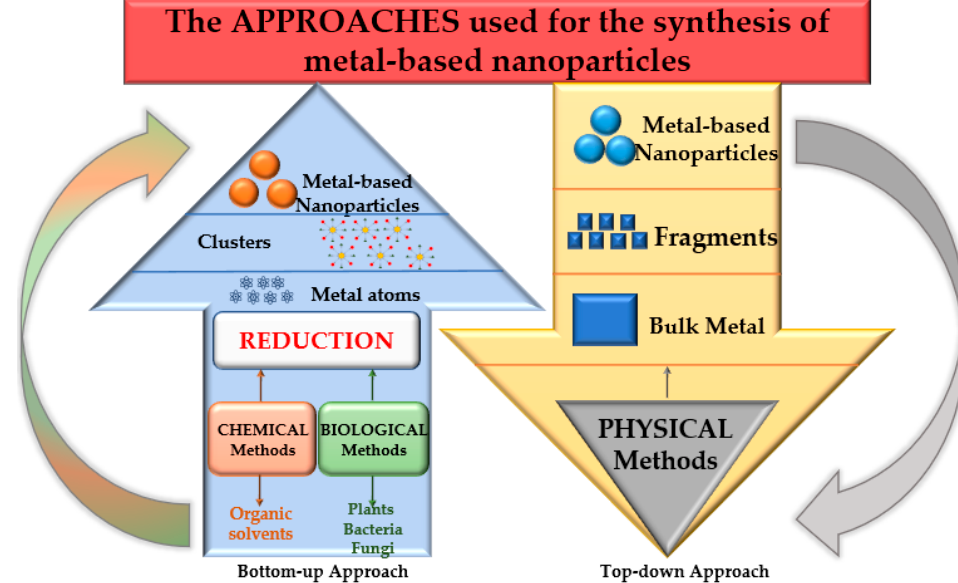
Figure 3. Bottom-up and top-down approaches for NP synthesis.